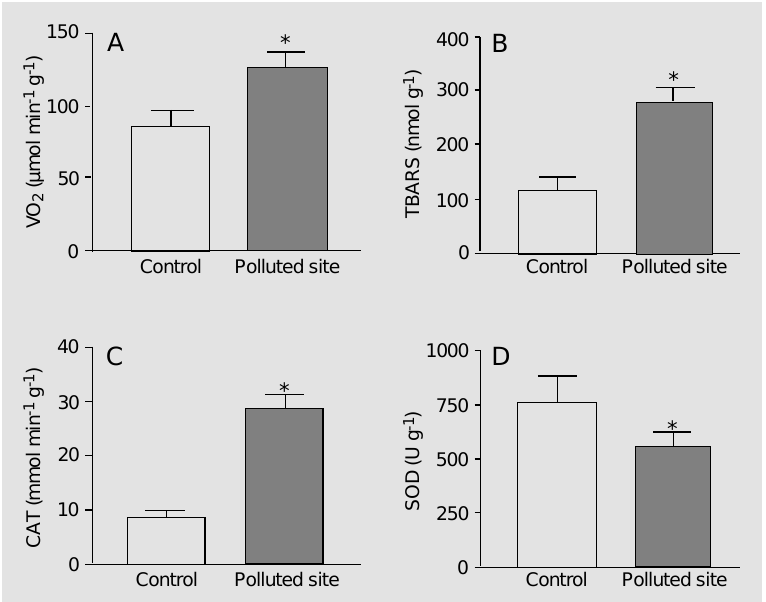
Figure 1. Comparison between different parameters measured in the liver of Geophagus brasiliensis collected at the polluted and at a reference site (control). A , Oxygen consump- tion (VO 2 , µmol min -1 g -1 ); B , cellular damage (TBARS, nmol g -1 ); C , catalase activities (CAT, mmol min -1 g -1 ); D , superoxide dismutase activities (SOD, U g -1 ). *P<0.05 compared to control (Student t-